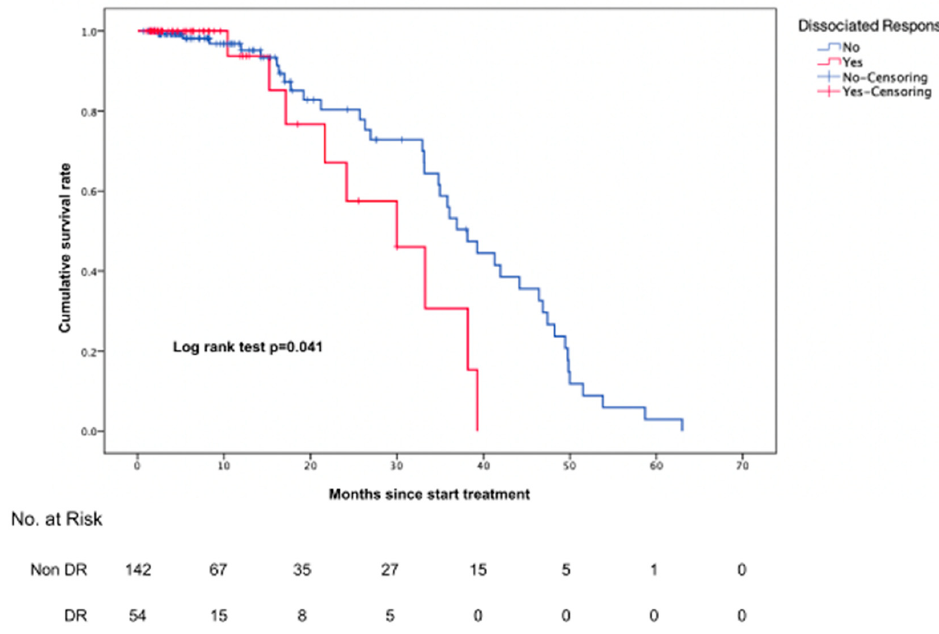
Figure 2. Comparison of overall survival between patients with a DR and those without a DR.